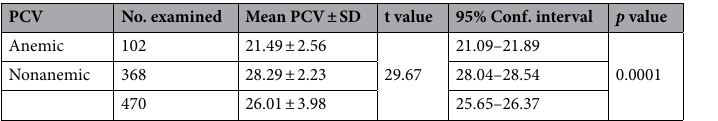
Table 2. Mean PCV of infested and noninfested animals found in Dasenech and Salamago Districts.